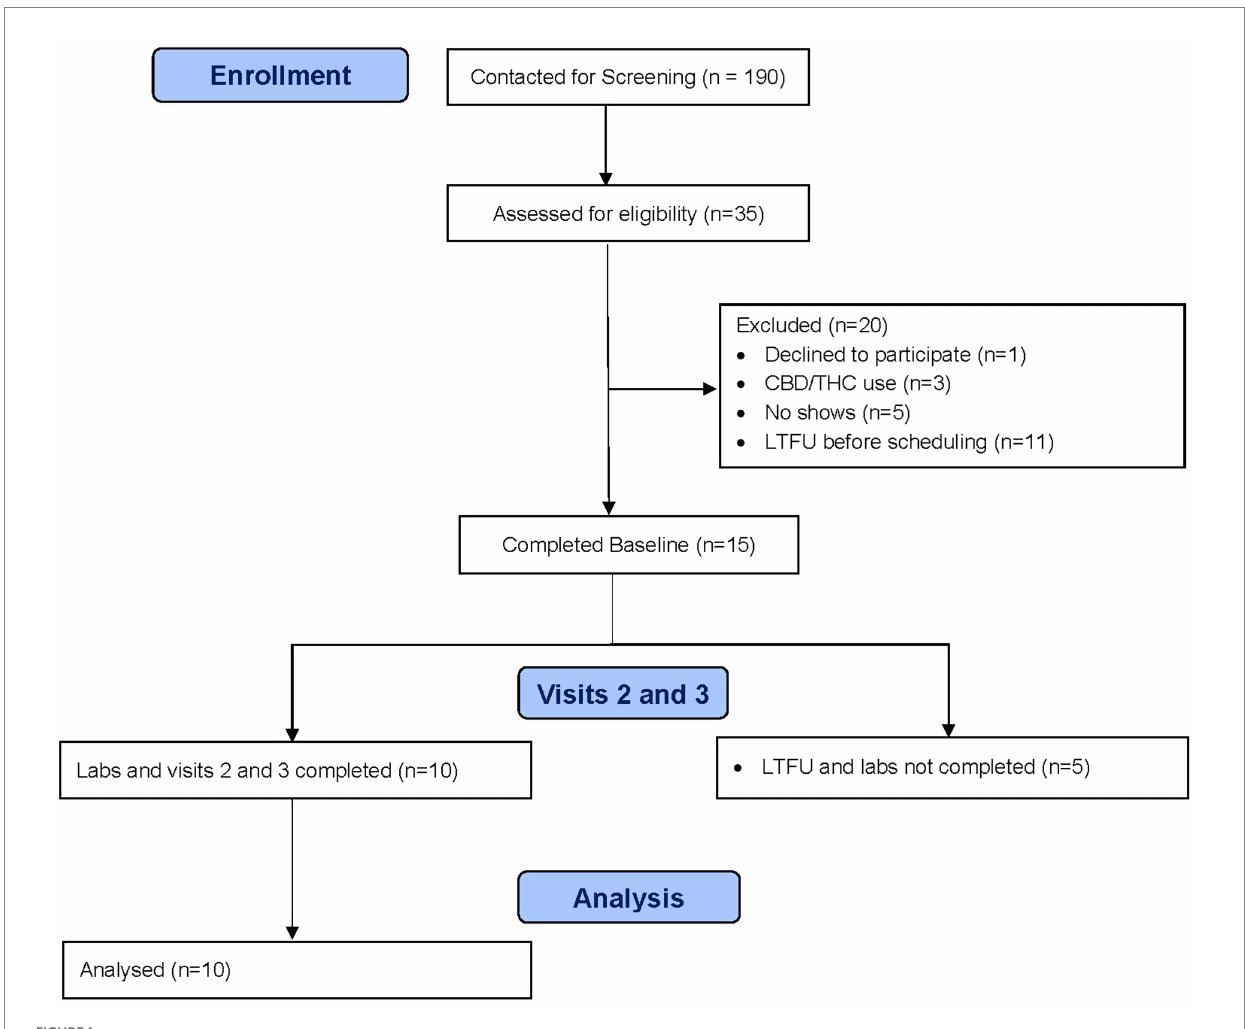
FIGURE 1 Study CONSORT flow